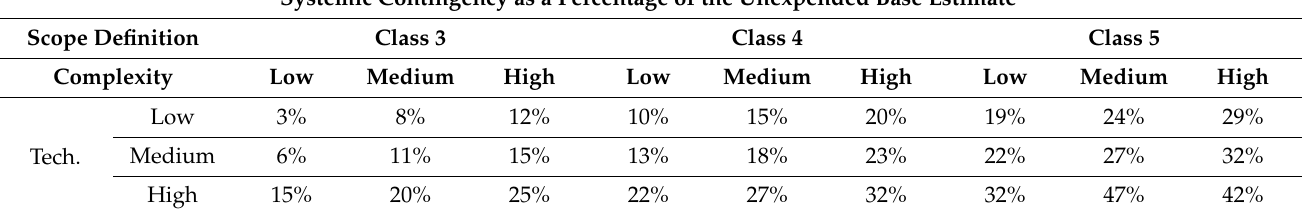
Table 6. Typical systemic contingency allowances based on project attributes by Hollmann, J.K. [52]. Systemic Contingency as a Percentage of the Unexpended Base